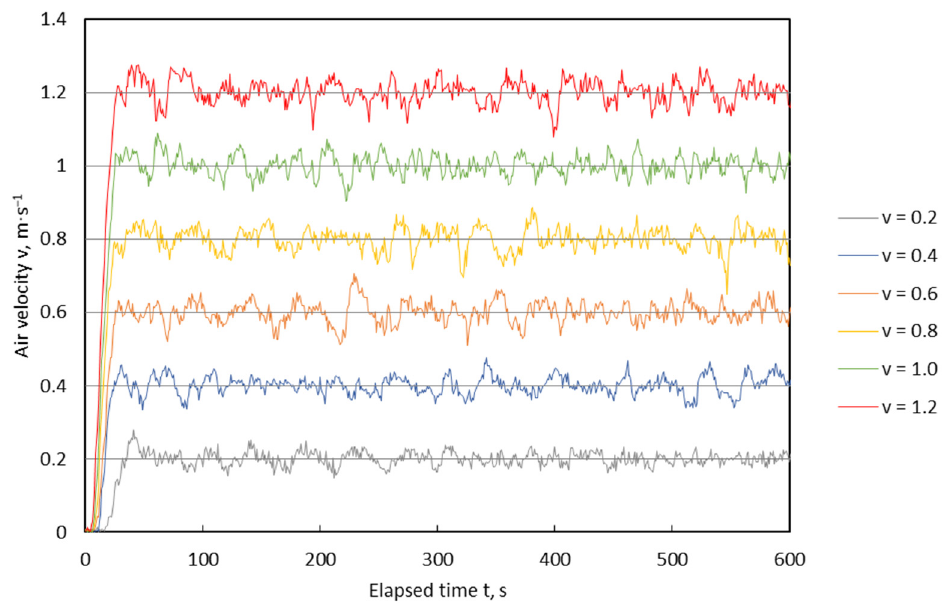
Figure 5. Air velocity vs. time; air velocity (v meas ) in the high-precision drying unit with empty sam- ple trays at different v set in the HPD TF3+ during calibration.